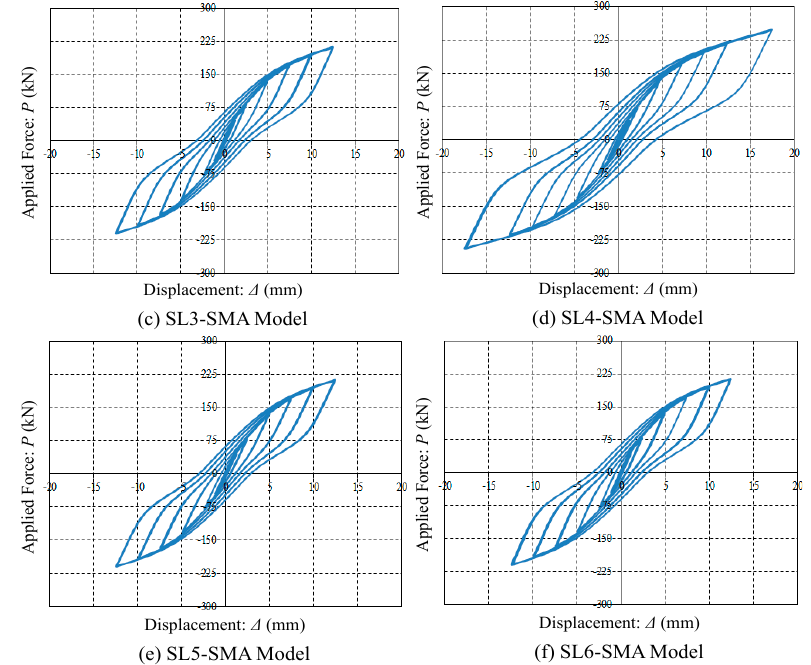
Figure 11. Applied force vs. displacement curves for recentering slit damper models, ( a ): SL1 SMA Model; ( b ): SL2 SMA Model; ( c ): SL3 SMA Model; ( d ): SL4 SMA Model; ( e ): SL5 SMA Model and ( f ): SL6 SMA